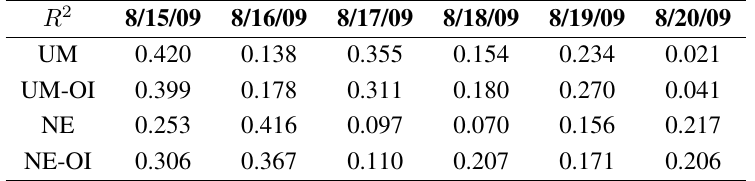
Table 2. Correlation between CMAQ PM2.5 predictions and AIRNow hourly observations in Upper Midwest (UM) and Northeast (NE) US before and after (OI) MODIS AOD assimilation. R